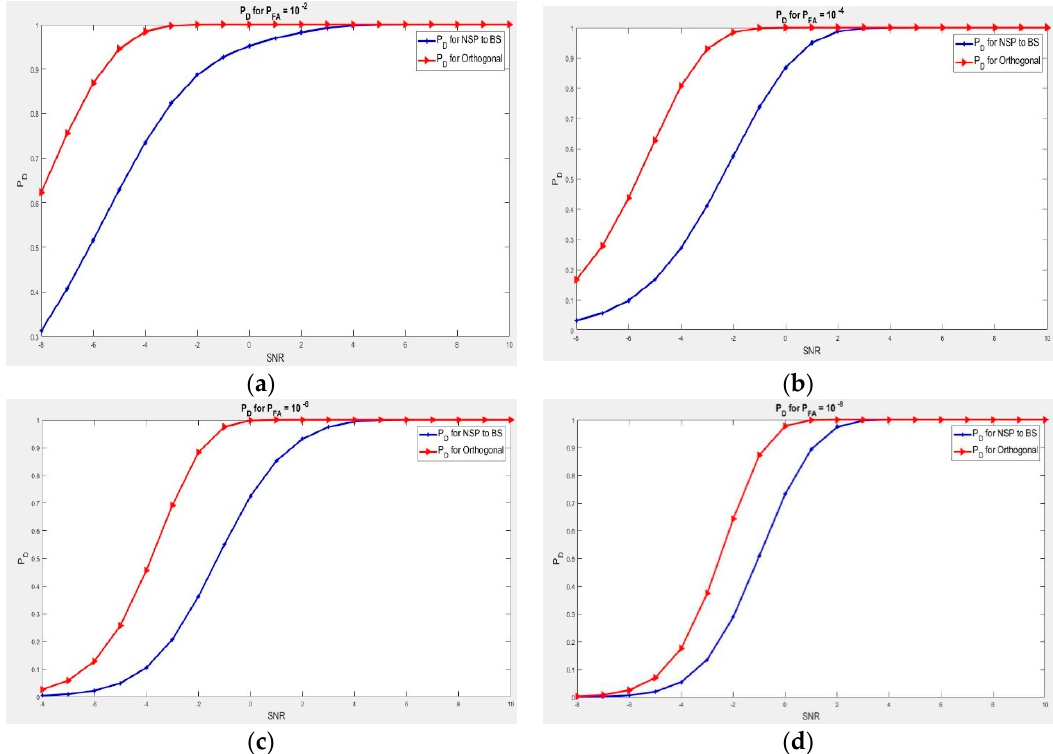
Figure 4. ( a ) Detection probability for SNR. Dimension N ( H i ) = 2, P f = 10 − 2 , and 3.6 dB is needed to have the same result with orthogonal waveform; ( b ) Detection probability for SNR. Dimension N ( H i ) = 2, P f = 10 − 4 , and 4.1 dB is needed to have the same result with orthogonal waveform; ( c ) Detection probability for SNR. Dimension N ( H i ) = 2, P f = 10 − 6 , and 2.9 dB is needed to have the same result with orthogonal waveform.; ( d ) Detection probability for SNR, Dimension N ( H i ) = 2, P f = 10 − 8 , and 1.8 dB is needed to have the same result with orthogonal